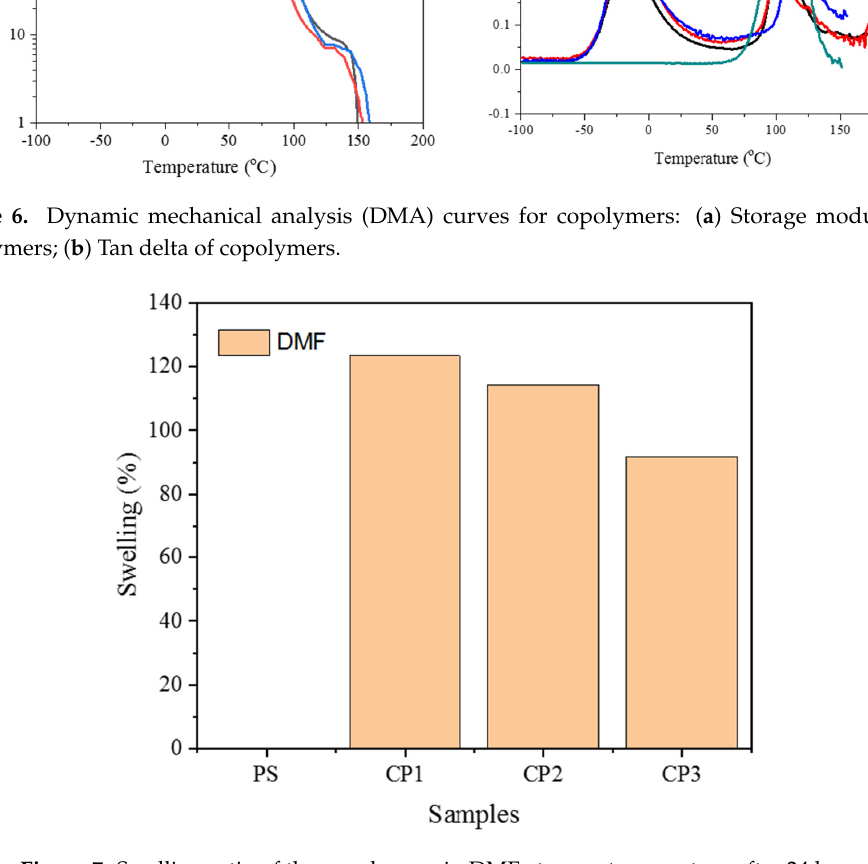
Figure 7. Swelling ratio of the copolymers in DMF at room temperature after 24 hrs. Table 2. Summary of tensile properties, DMA, and TGA data of copolymers.